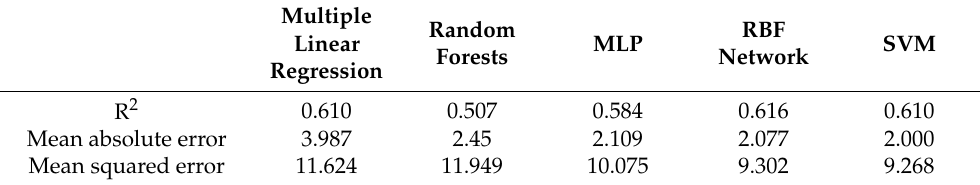
Table 2. Evaluation metrics for the regression analysis of LOS, measured in days.